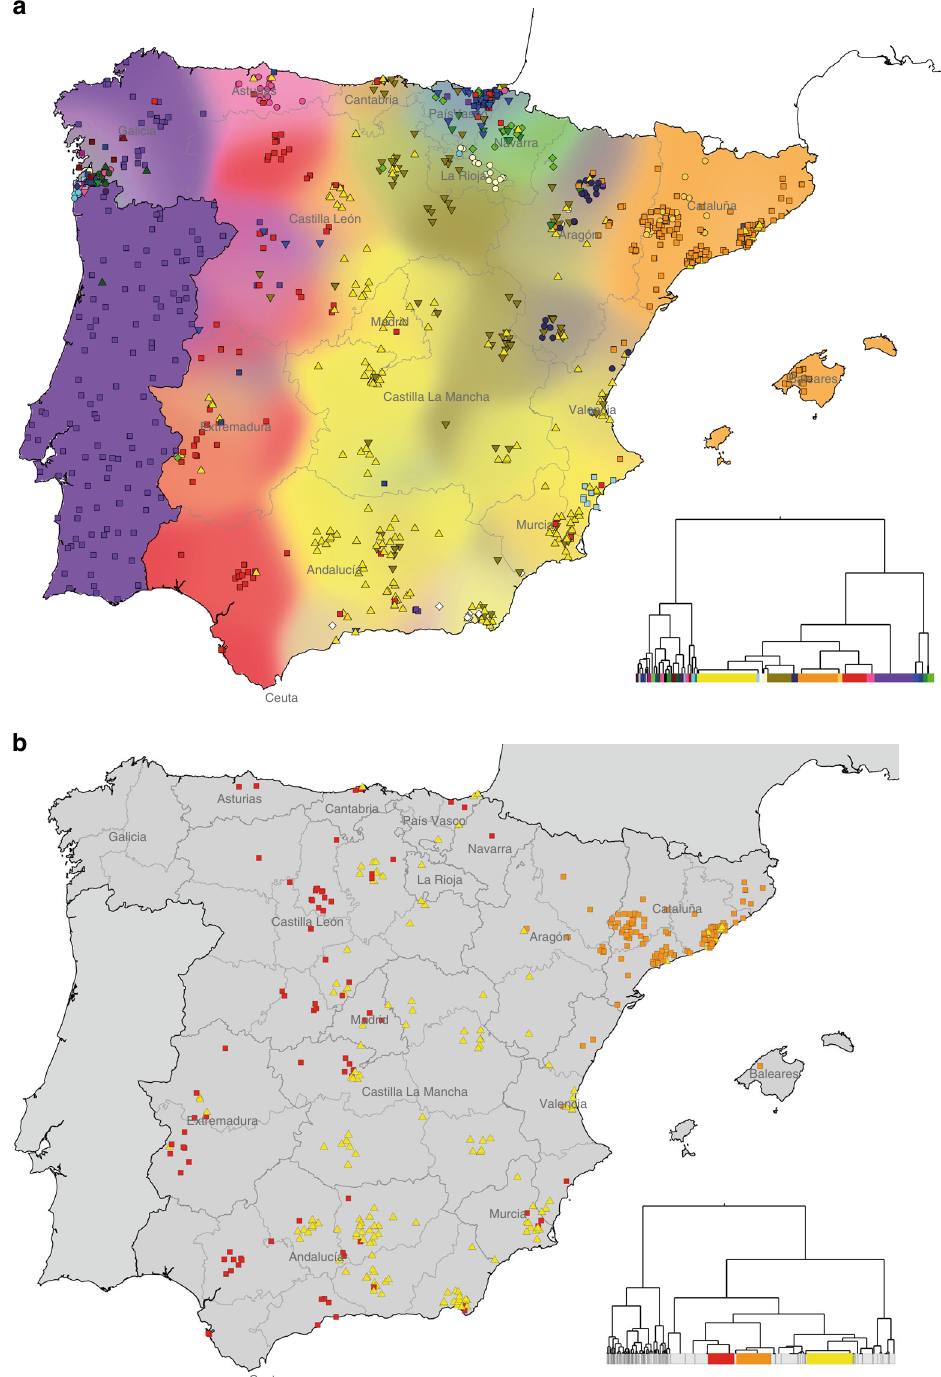
Fig. 2 Clustering analysis including Portuguese individuals; and large clusters at the bottom of the tree. a This map and tree show clusters inferred by fi neSTRUCTURE (analysis B) that included data from Portuguese individuals but using a smaller set of SNPs (Methods). As in Fig. 1b we show the level of tree such that all clusters contain at least 15 individuals (39 clusters). Points representing 843 individuals are shown on this map but, as with analysis A, data for all Portuguese and Spanish individuals (1530) were used in the inference. Positions of points and background colours are determined using the same procedure as for Fig. 1b (Methods), with the exception of Portugal. No fi ne-scale geographic information was available for these individuals, so we placed them randomly within the boundaries of Portugal and show a single background colour. b This map shows geographic spread of the three large clusters that remain at the bottom of the tree inferred in the Spain-only fi neSTRUCTURE analysis (see main text; Fig. 1a). These clusters each contain more than 100 individuals out of the full set of 1413. The accompanying tree highlights the three clusters within the full tree structure. The width of the coloured rectangles is proportional to the number of individuals belonging to each cluster (yellow = 222; orange = 165; red =